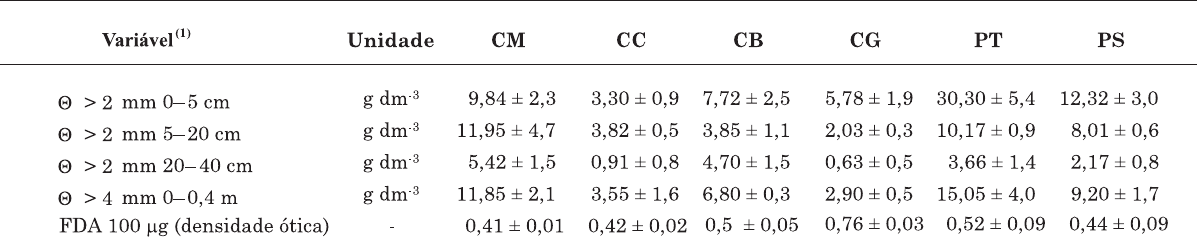
Quadro 1. Valores (média ± erro padrão) de fragmentos orgânicos e da atividade enzimática do diacetato de fluoresceína de amostras de solo dos grupos de sítios de restinga estudados: CM = Caju mata; CG = Caju capim gengibre; CB = Caju coqueiral de banco de germoplasma; CC = Caju capoeira; PT = Pirambu mata de topo; PS = Pirambu mata de sopé. n =